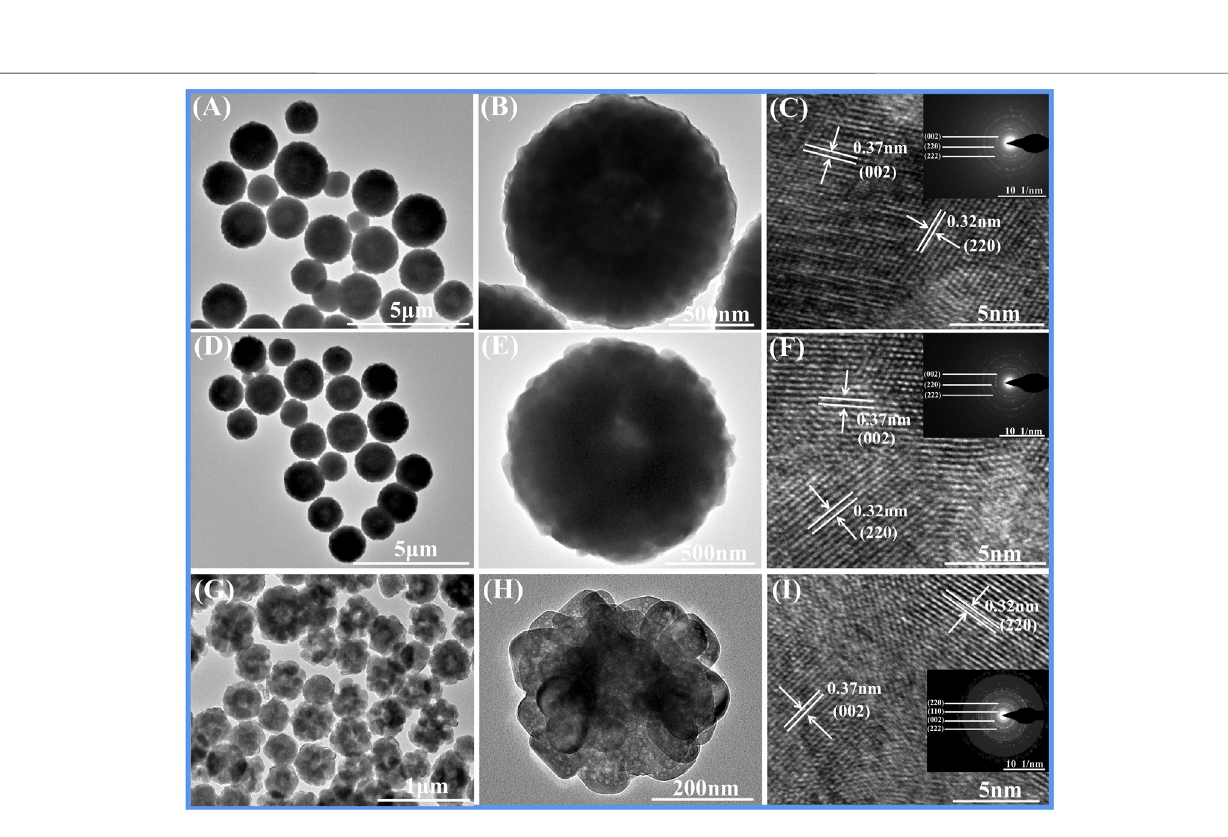
Figure 3A . The diffraction peaks of products perfectly match the